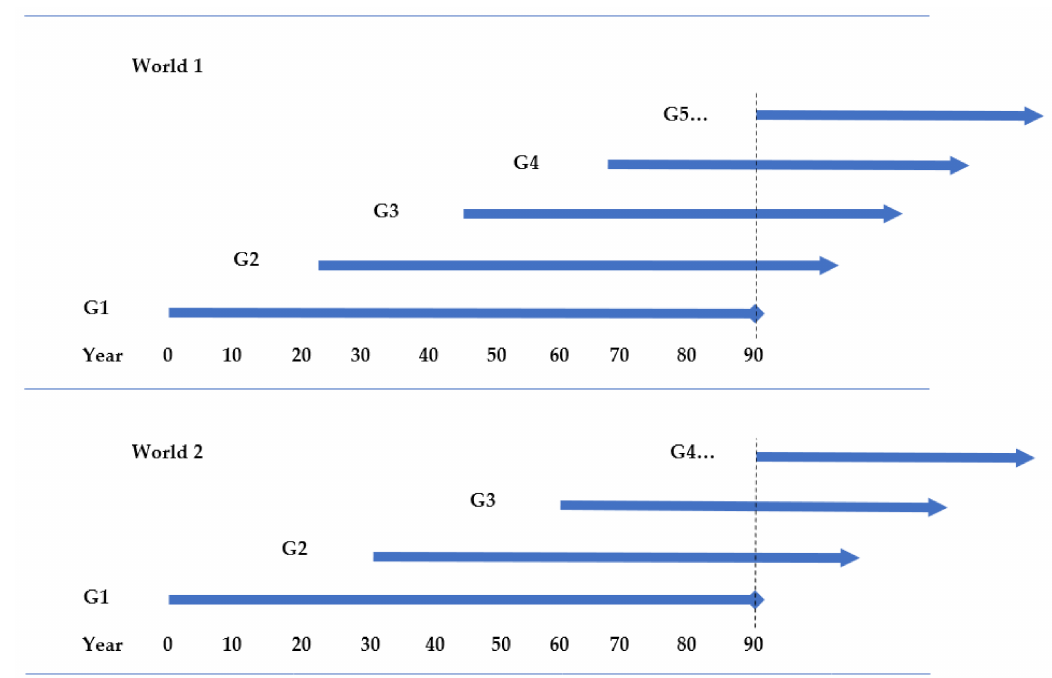
Figure 1. How differences in reproductive timing affect the number of generations living